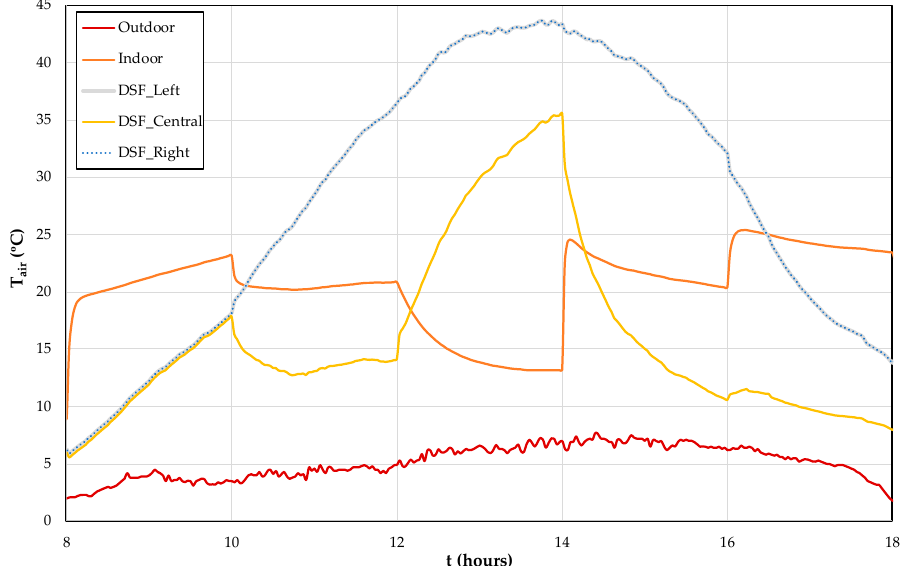
Figure 19. Evaluation of air temperature (T air ) of the outdoor environment, indoor virtual chamber and indoor left, central and right DSF system, when the airflow rate is variable and the number of DSFs to operate is variable, for the Case G.